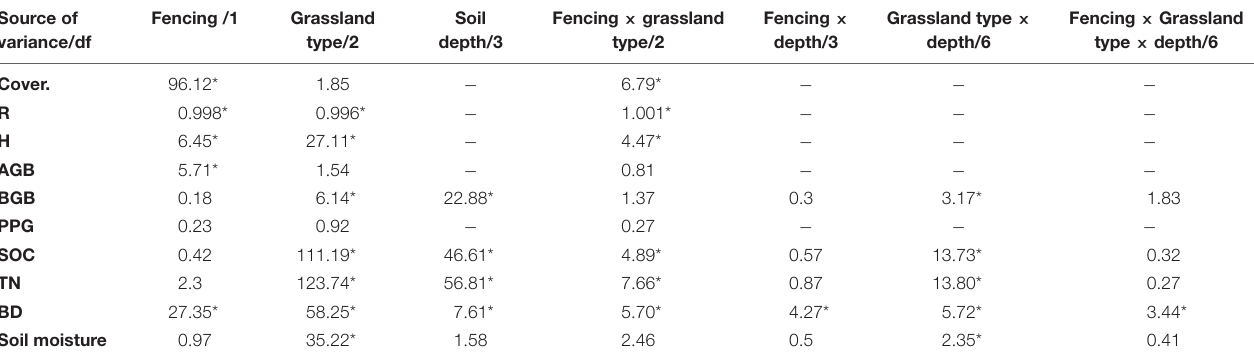
TABLE 3 | Results ( F value) of three-way ANOVA analysis about the effect of fencing, depth, grassland type, and interaction of fencing and grassland type, fencing and depth, grassland types and depth, fencing with grassland type and depth on total coverage (Cover.), plant species richness (R), Shannon–Wiener diversity index (H), aboveground biomass (AGB), belowground biomass (BGB), proportion of palatable grasses (PPG), soil organic C (SOC), total nitrogen (TN), soil bulk density (BD), and soil moisture.